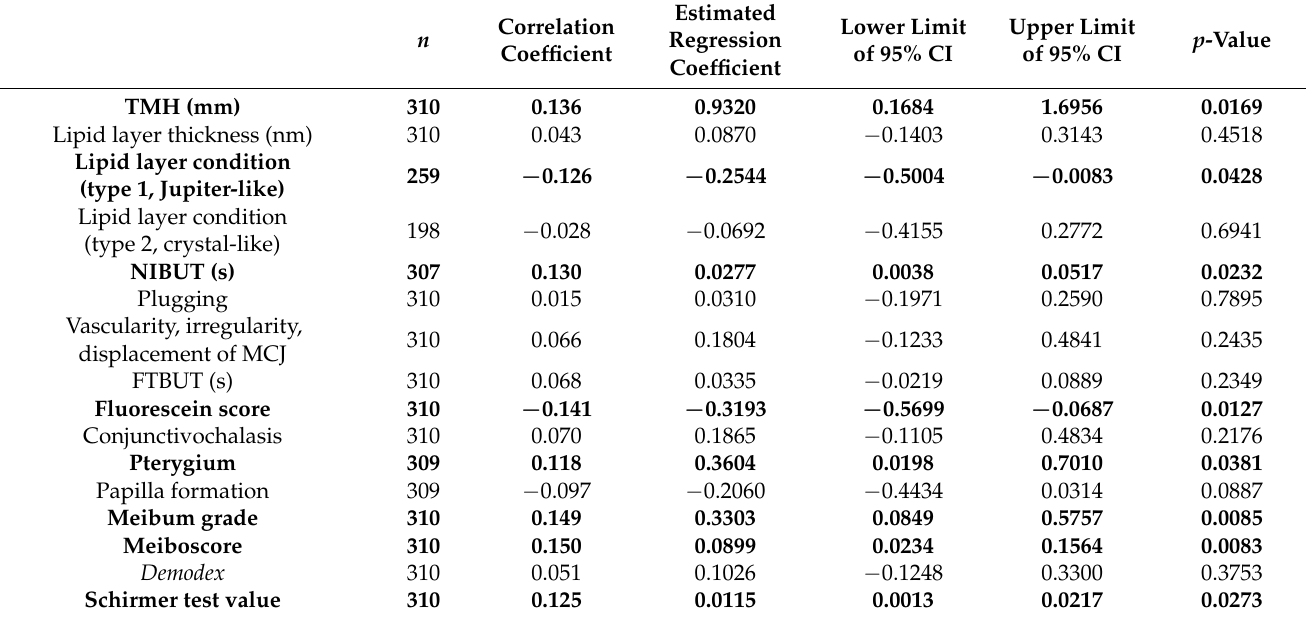
Table 5. Pearson’s coefficient analysis of the relation between ocular surface parameters and teary sensation. Estimated Lower Limit Correlation n Regression n Coefficient Coefficient